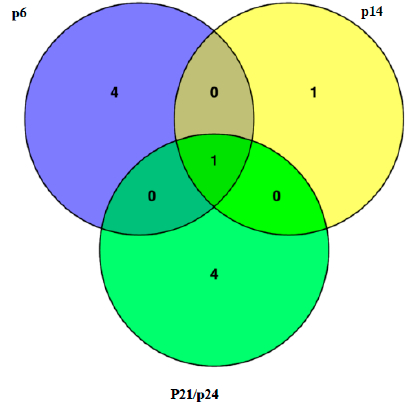
Figure 2. Identification of the Msd3 gene by MutMap. Four F2 populations, BTx623*p6, BTx623*p14, BTx623*p21, and BTx623*p24, were subjected to sequencing of 20 bulked F2 mutants. The number in each circle represents the number of homozygous deleterious mutations. Only one gene, Sorbi_3001G407600, was commonly mutated in all four populations. In p21 and p24, the MSD3 gene was mutated at the same position.